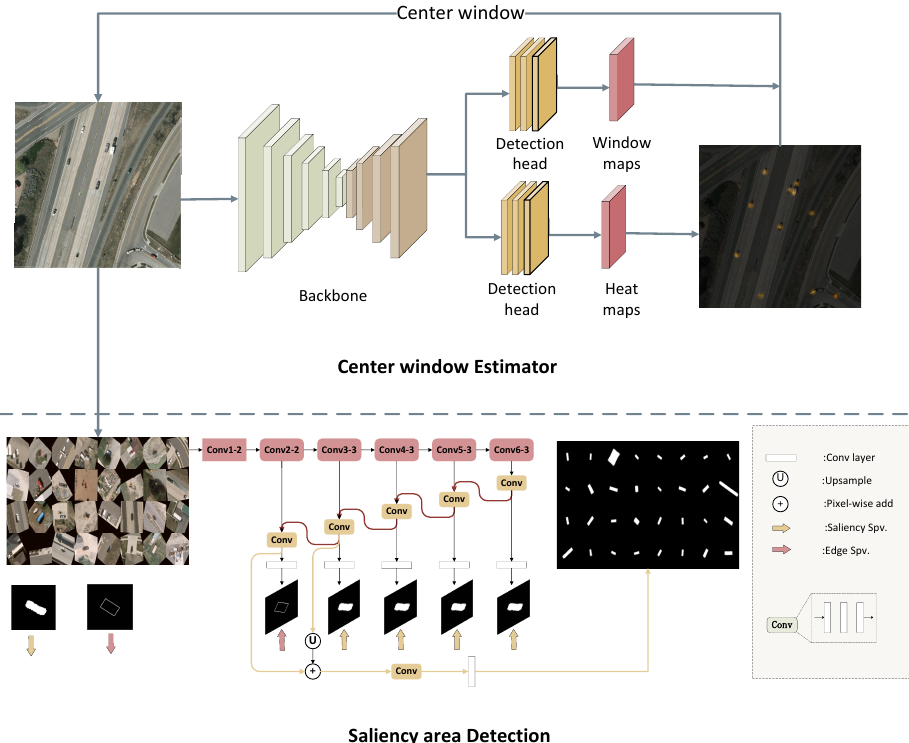
Figure 5. An overview of SR-Net. The model is divided into two main parts: the center window estimator module and the saliency region detection module. The saliency region detection module is cascaded behind the center window estimator module. The output of the center window estimator module is used as the input of the saliency region detection